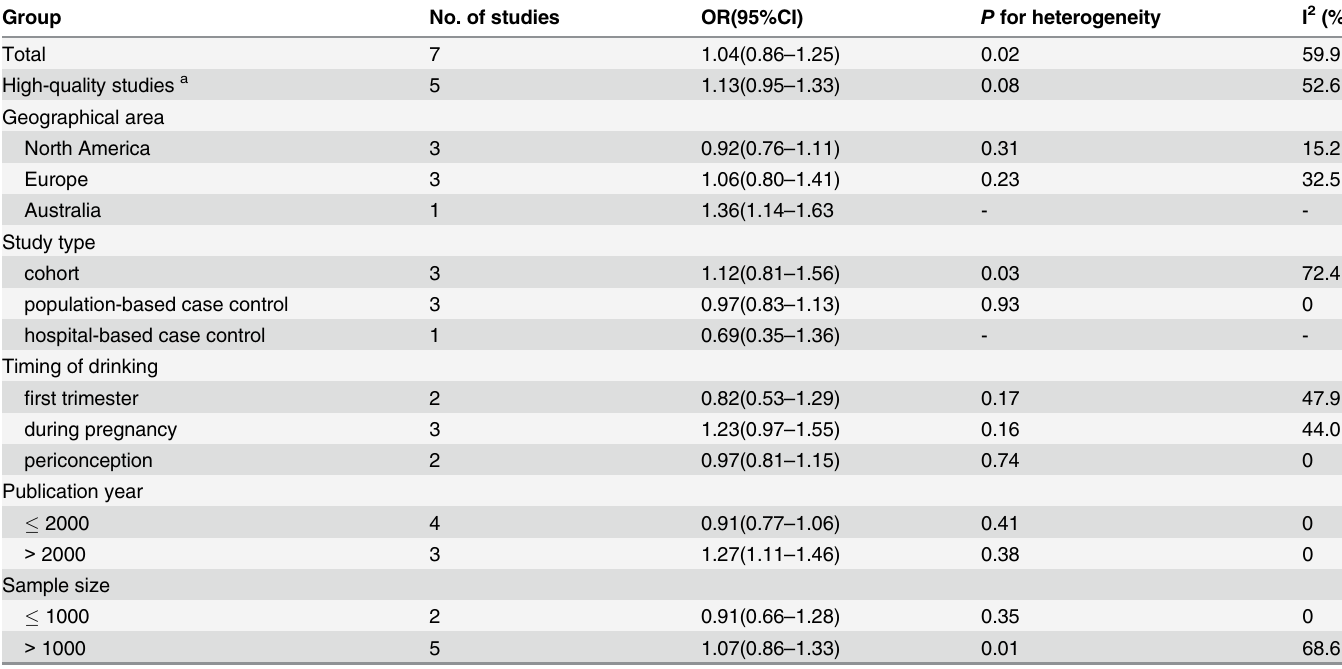
Table 2. Summary results of the association between prenatal alcohol exposure and ventricular septal defects risk.